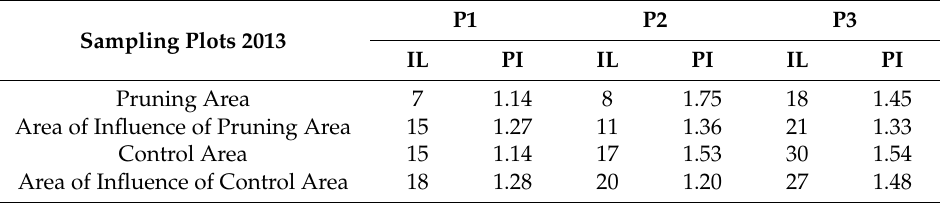
Table 3. Values of Infestation Level (IL) in %, and Population Intensity (PI) in average number of dry branches/tree, corresponding to each sampling area established inside each sampling plot (P1, P2, and P3) in 2013.